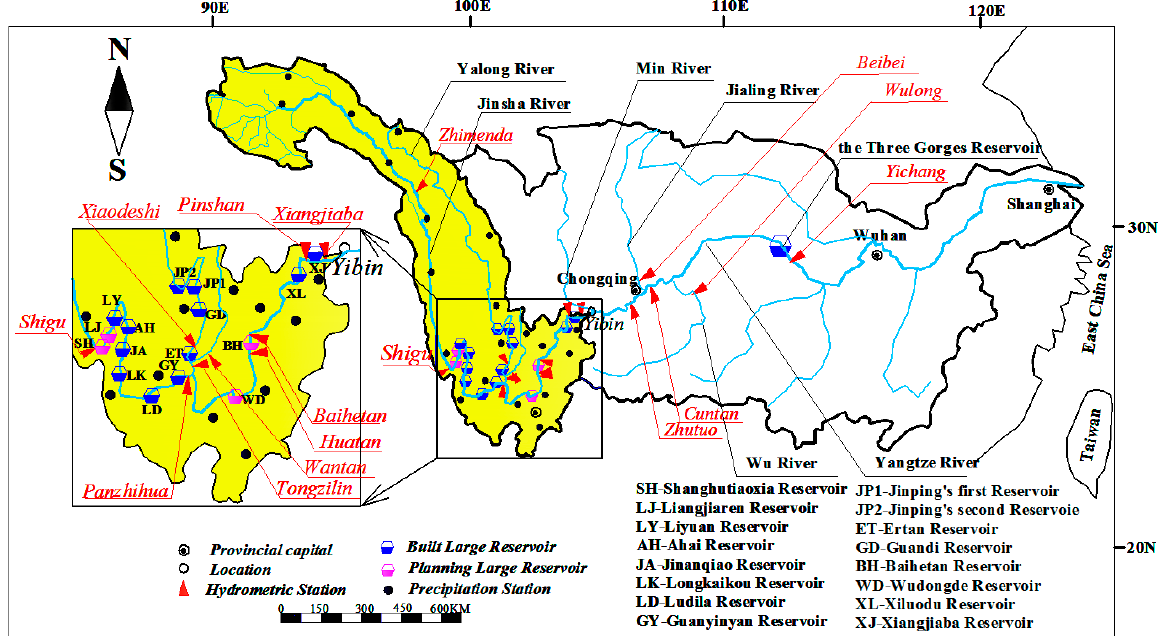
Figure 1. Simplified map of the Jinsha River Basin showing the main stream, tributaries, large reservoirs, and hydrological and precipitation stations. The area within the square is enlarged in the inset.